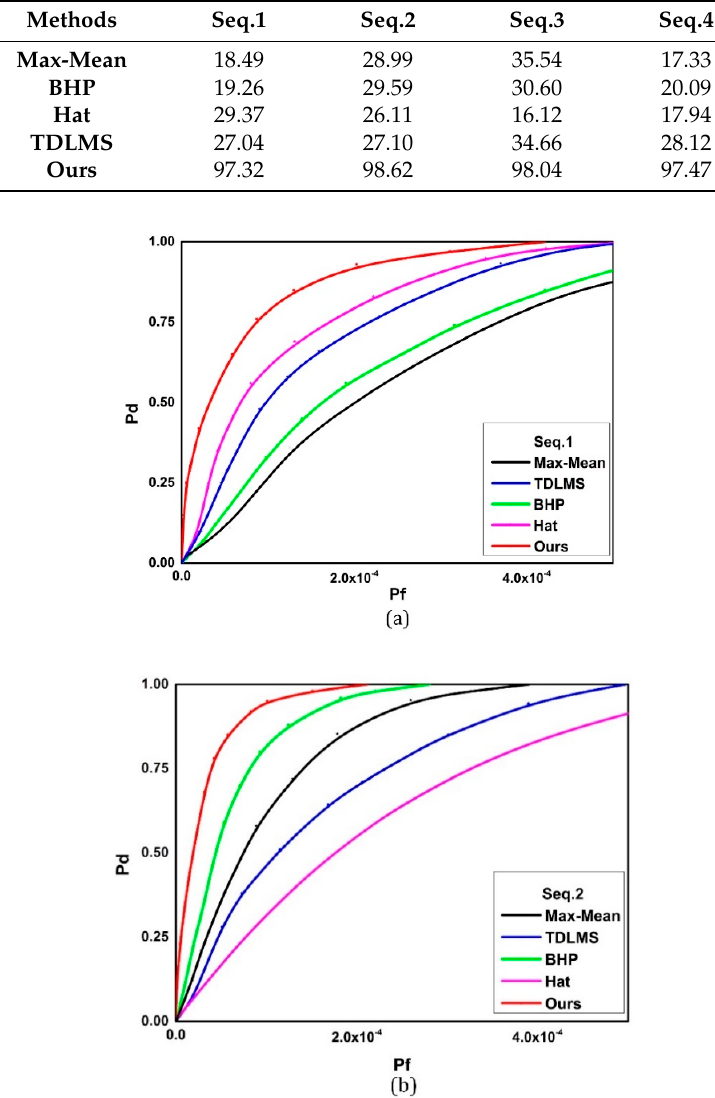
Table 3. Statistical results of η (%) for the inter-frame detection.